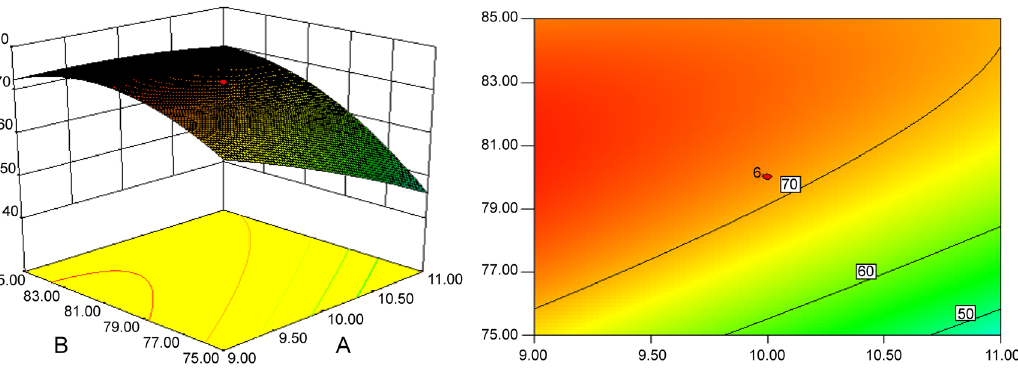
Figure 8: Response surface figure and contour map of sample solution pH value (A) and eluent concentration (B). The range of A is from 9 to 11, and the range of B is from 75 to 80%.